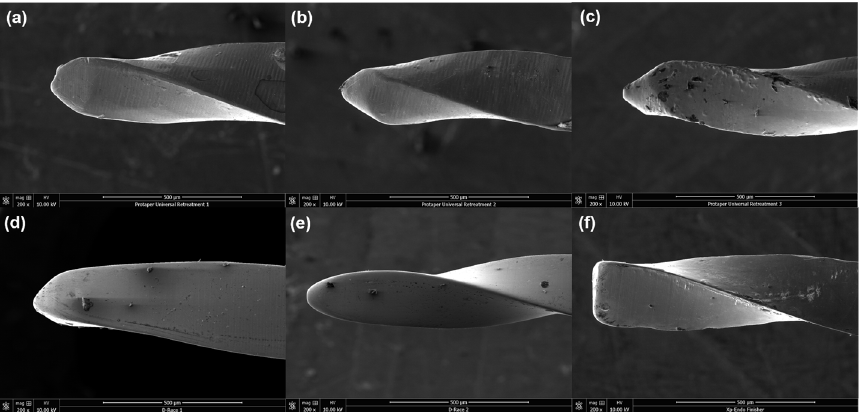
Figure 1. SEM images of the tips of ( a – c ) the ProTaper Universal Retreatment D1, D2 and D3, ( d , e ) the D ‐ Race DR1 and DR2; and ( f ) the XP–Endo Finisher R